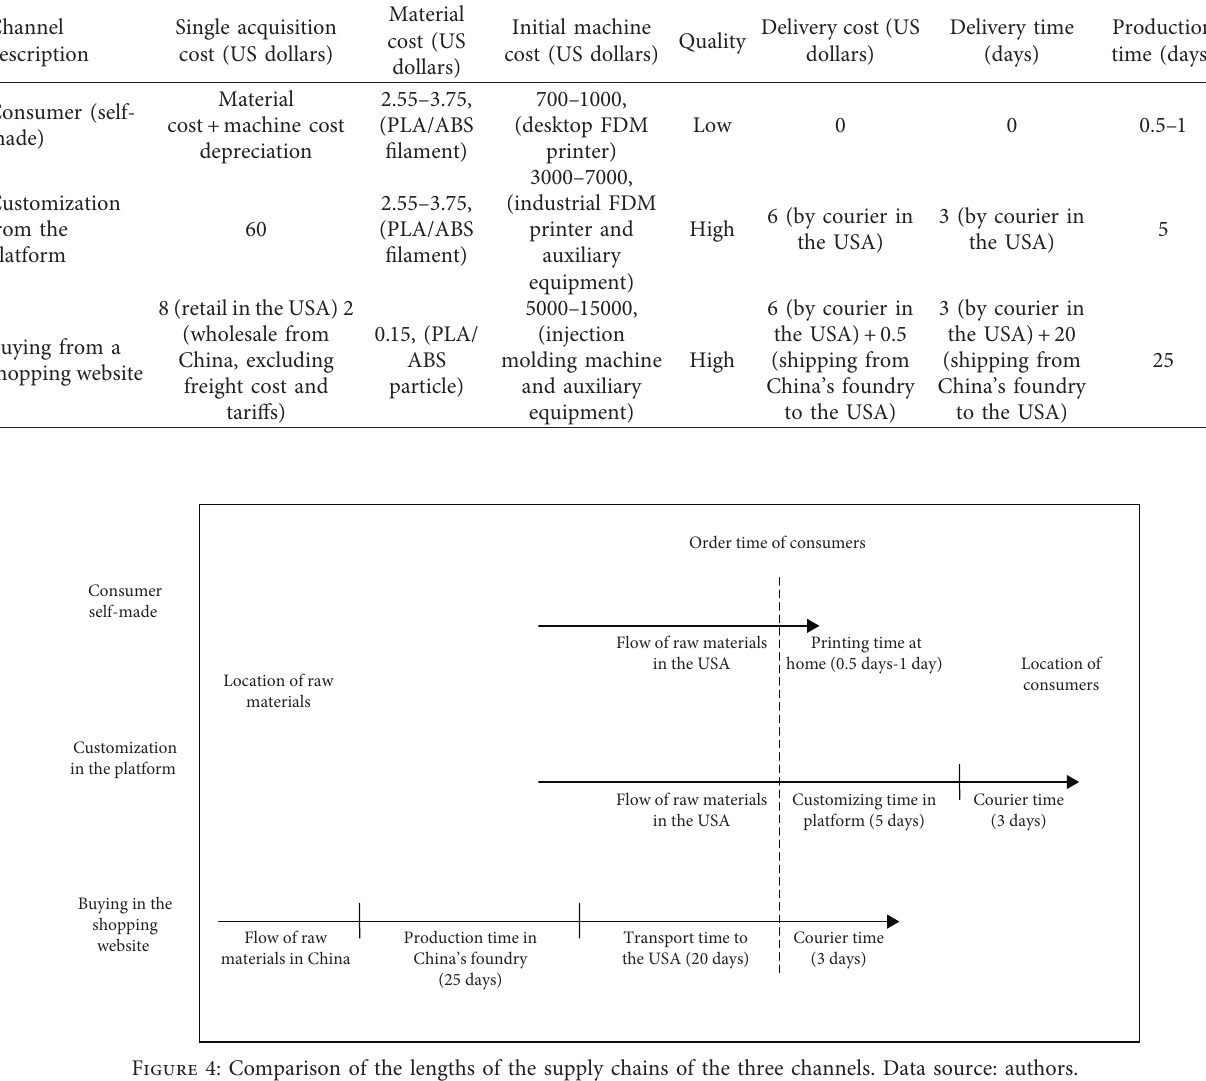
Table 1: Comparison of the three channels. Data source: Shapeways (https://www.shapeways.com), Amazon (https://www.amazon.com), and Alibaba (https://www.alibaba.com).